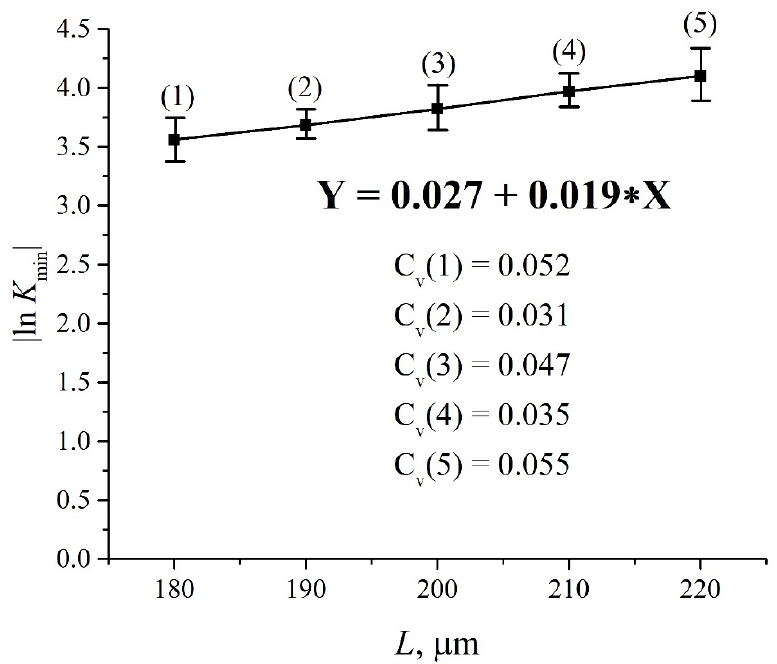
Figure 4. Dependences |ln K min | vs. L for deionized water.